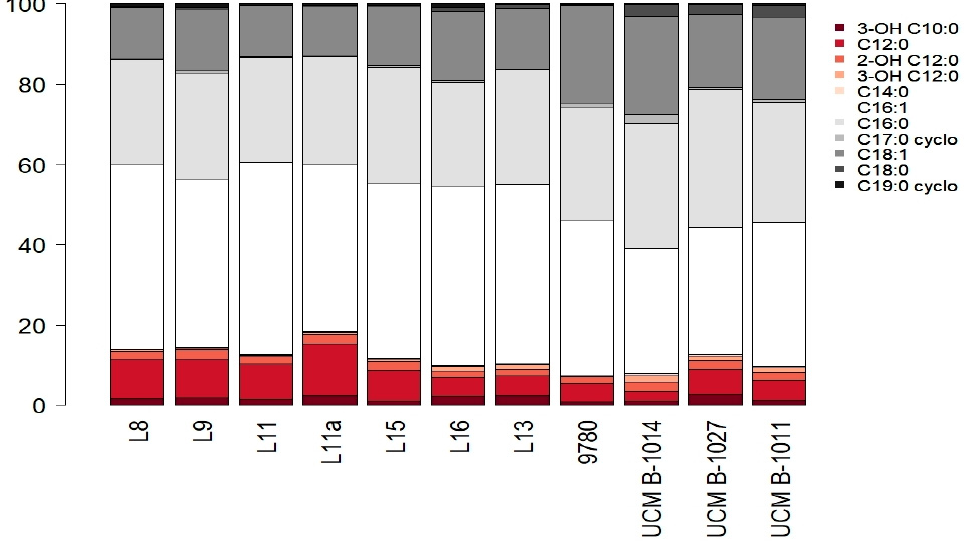
Figure 2. The fatty acid composition of the total cellular lipids of P. syringae isolates.